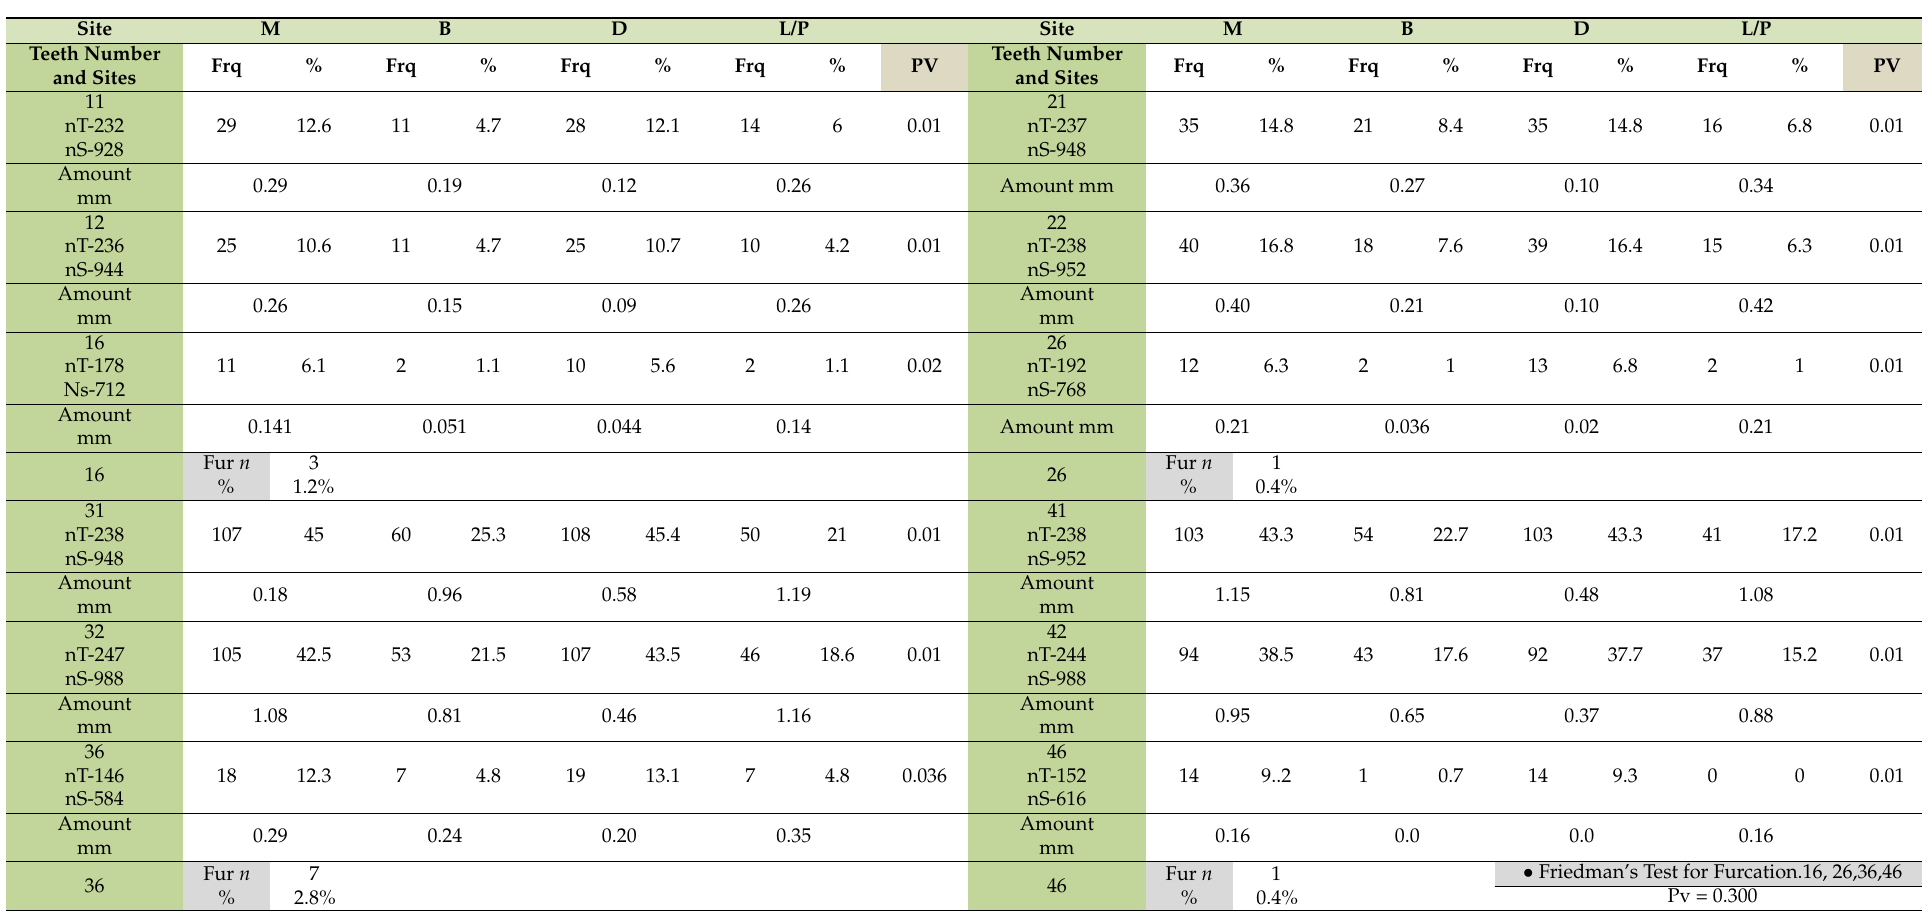
Table 3. Comparison of bilateral site distribution of the corresponding maxillary and mandibular teeth for frequency, percentage, and amount of bone loss at the 1st molars and incisors, plus 1st molars’ furcation defects, among the total number of sites (nS) of all teeth (nT) examined in this